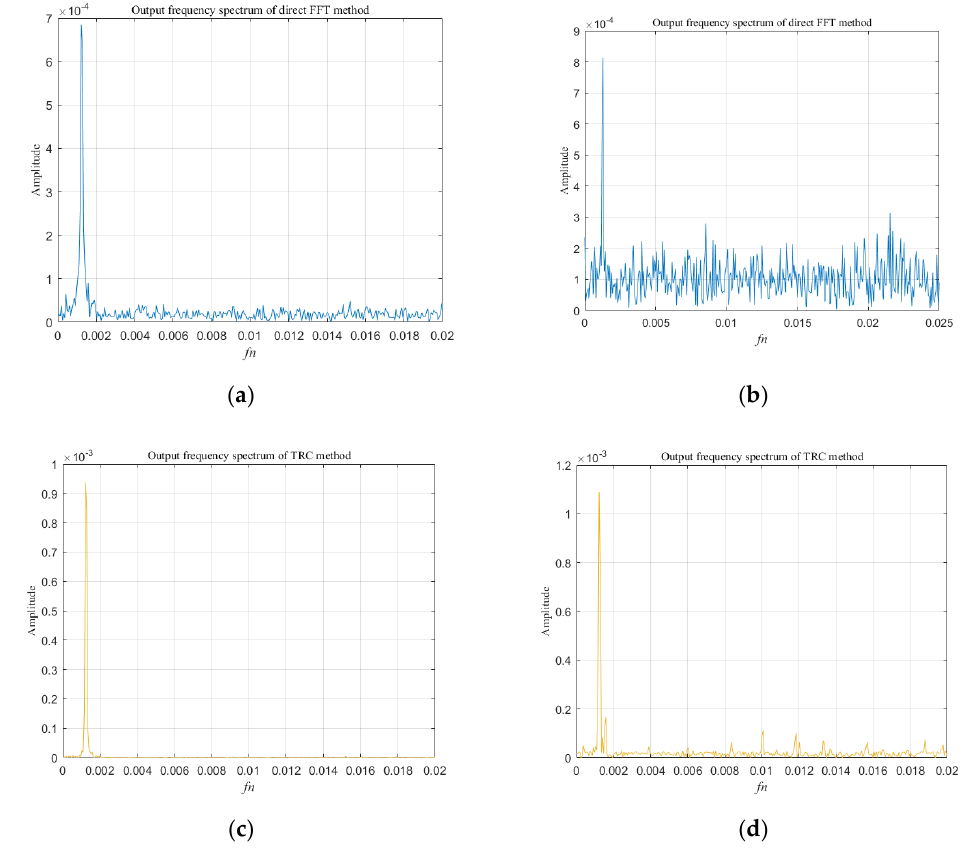
Figure 4. The frequency spectrum of the output signal of direct fast Fourier transform (FFT) method and TRC method under different signal-to-noise ratio (SNR) conditions. ( a ) When SNR = − 5 dB, direct FFT method output spectrum; ( b ) When SNR = − 20 dB, direct FFT method output spectrum; ( c ) When SNR = − 5 dB, TRC method output spectrum; ( d ) When SNR = − 20 dB, TRC method output spectrum.